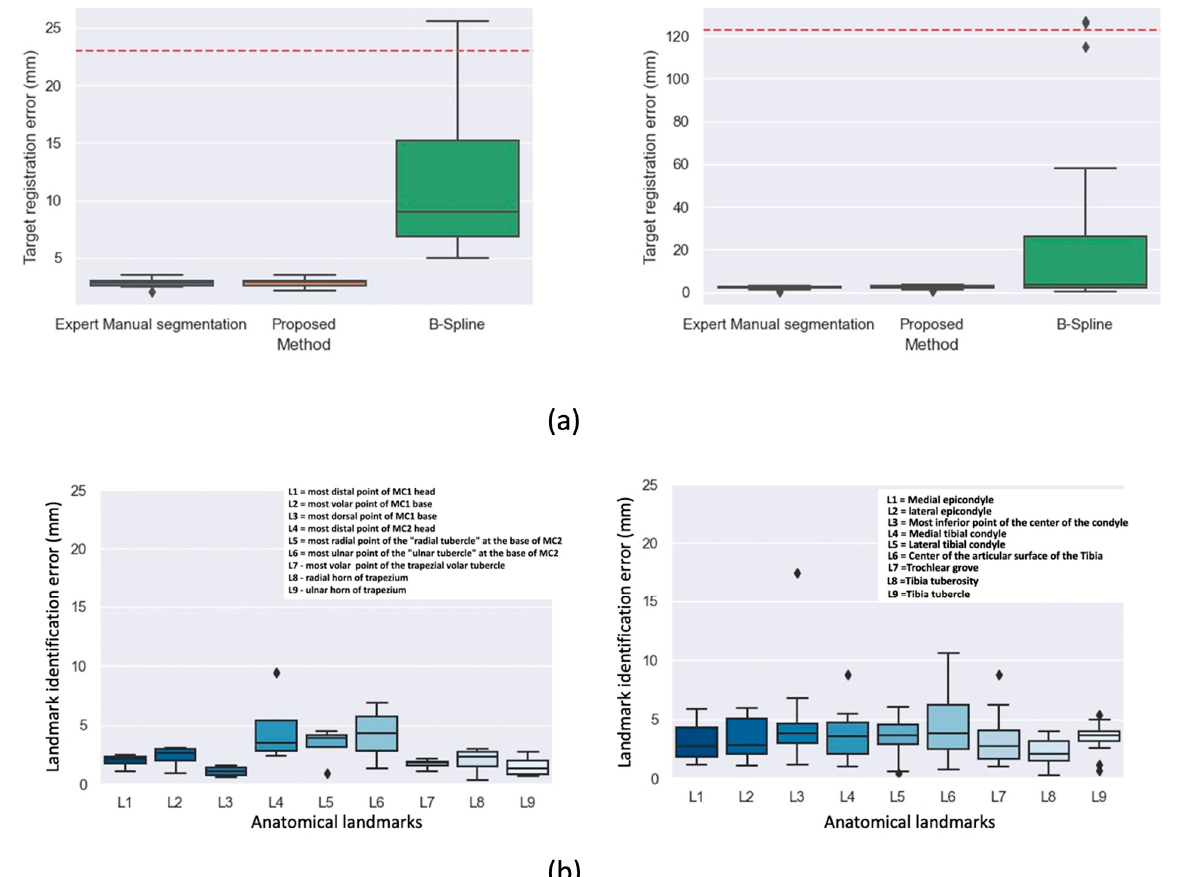
Figure 6. ( a ) Box plots showing TRE results of the piecewise rigid dynamic registration step for thumb base (top-left, n = 5) and the knee joint (top-right, n = 10). Results are shown for the expert manual segmentation approach, our multi-atlas guided approach (MAS) and a deformable registration (B-Spline). Dashed red lines indicate TRE for unregistered images ( b ) landmark identification error of the automatic anatomic landmark identification approach compared to the mean of all readers across 9 landmarks for thumb base (bottom-left) and the knee joint (bottom-right). The names of the anatomical landmarks are shown as inserts on the graphs.